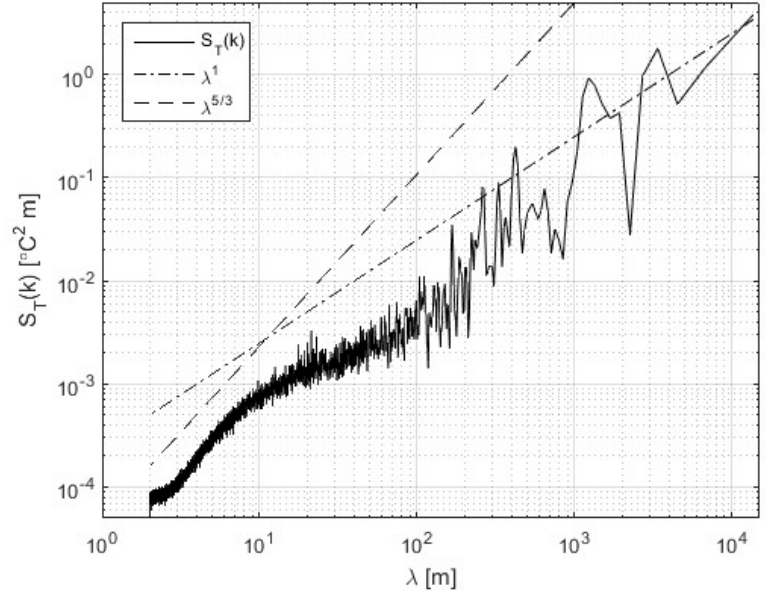
Figure 15. Temperature power spectrum calculated along raw infrared swaths (same swath as in Figures 7 and 14). Power law slopes of λ 1 and λ 5/3 are given by dash-dotted and dashed lines for reference.